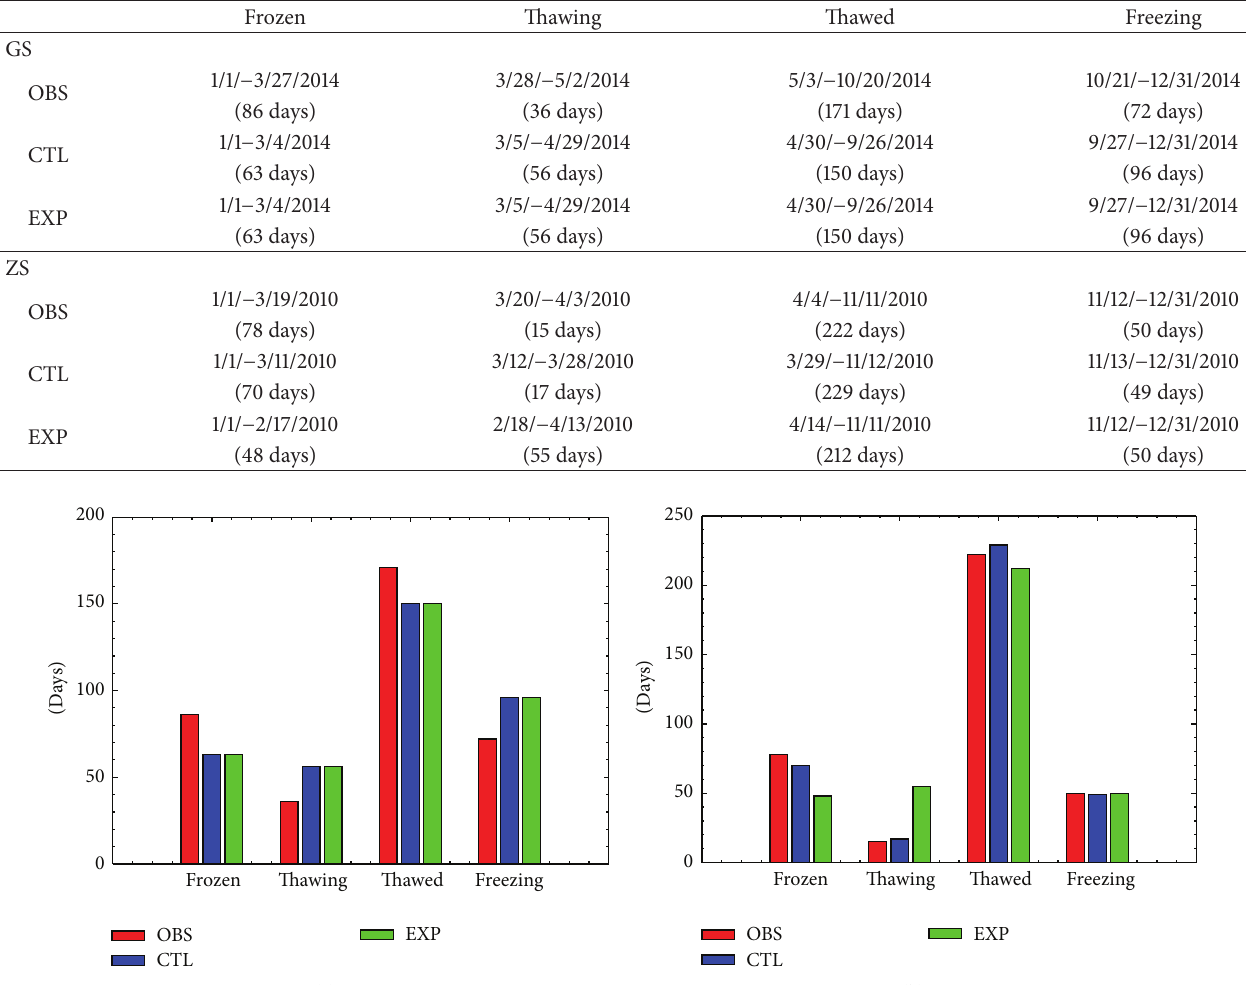
Table 7: Four freeze-thaw stages determined the daily maximum and minimum soil temperatures at 10 cm under the surface (month-days).